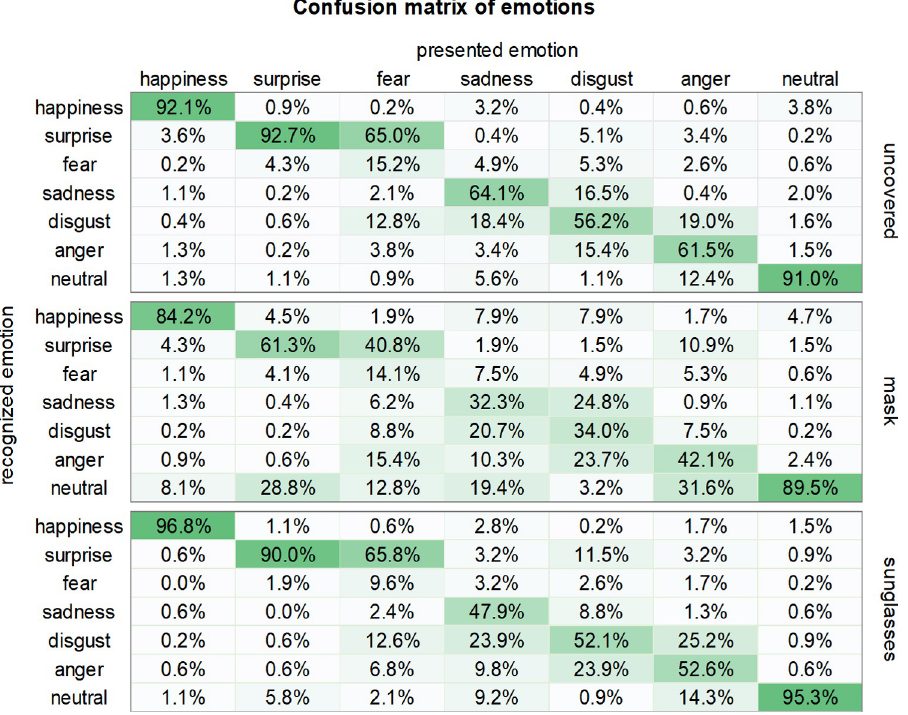
Fig 3. Percentage of participants responding to each emotion. Rows correspond to the recognized emotion (participants’ responses) and columns correspond to the presented (correct) emotion.